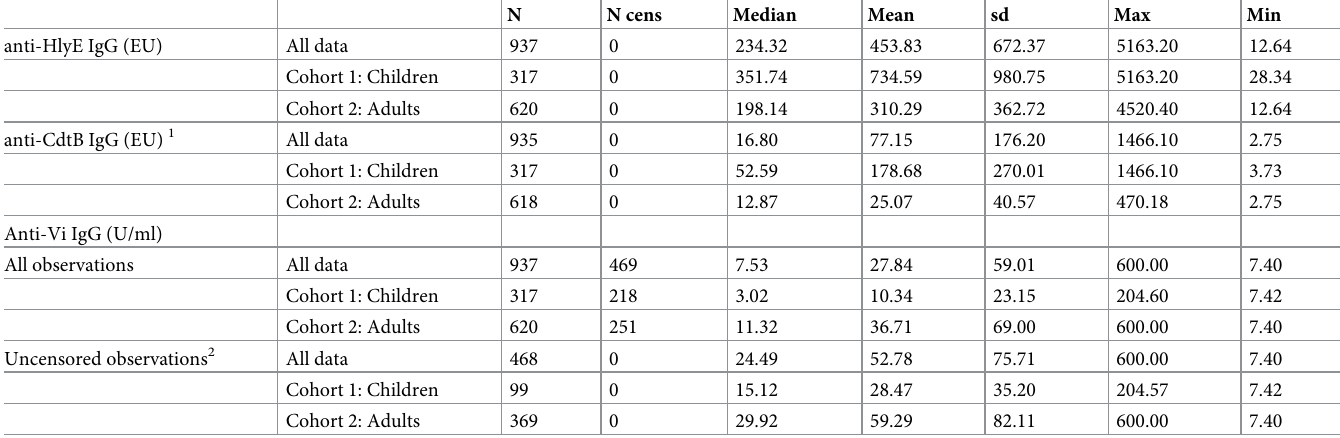
Table 2. Anti– S . Typhi serum IgG antibody titers in the adult and child cohorts.